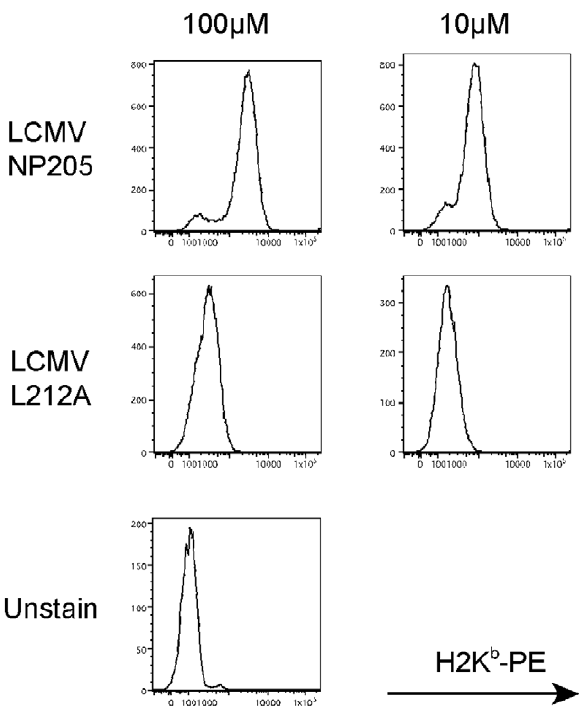
Figure 2. Lack of MHC stabilization by LCMV NP L212A. MHC stabilization assays for LCMV WT (NP205) and mutant (L212A) peptides. RMA-S cells were incubated with different concentrations of peptides and stained against H2K b to detect its stabilization on the cell